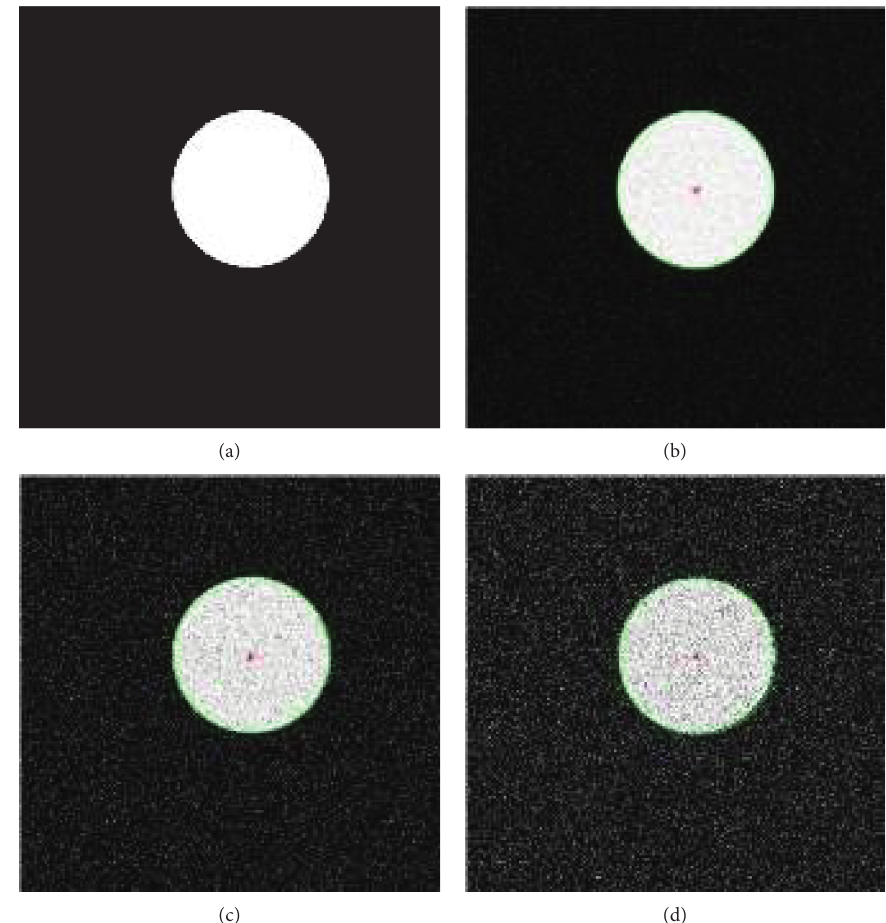
Figure 8: Circular detection effect of noise pollution. (a) Computer-generated image. (b) σ � 0.01 algorithm image. (c) σ � 0.05 algorithm image. (d) σ � 0.1 algorithm image.